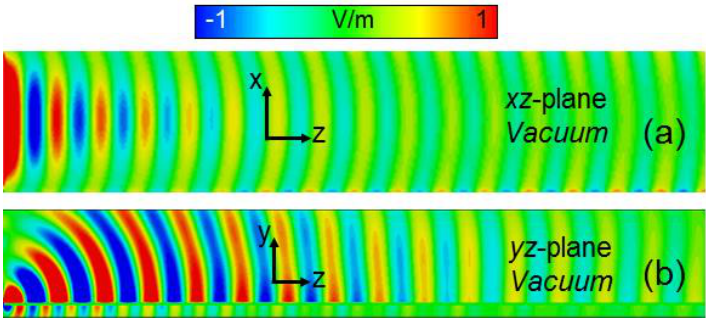
Figure 2. E y -field distribution on the xz -plane ( a ) and ( yz -plane) ( b ) for a flat gold film at 1550 nm.